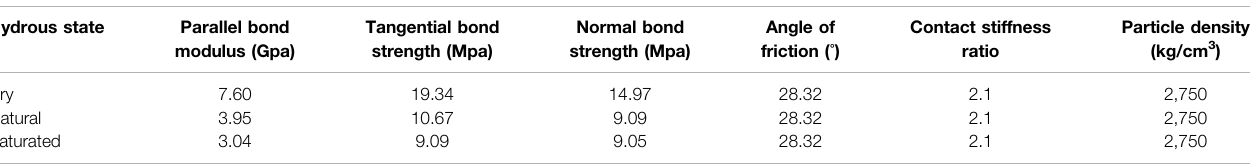
TABLE 3 | Microscopic parameter table of PFC for the specimen. Hydrous